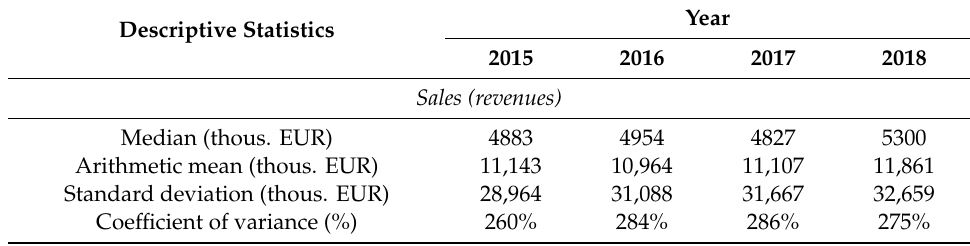
Table 2. Descriptive statistics of variables entering the earnings management